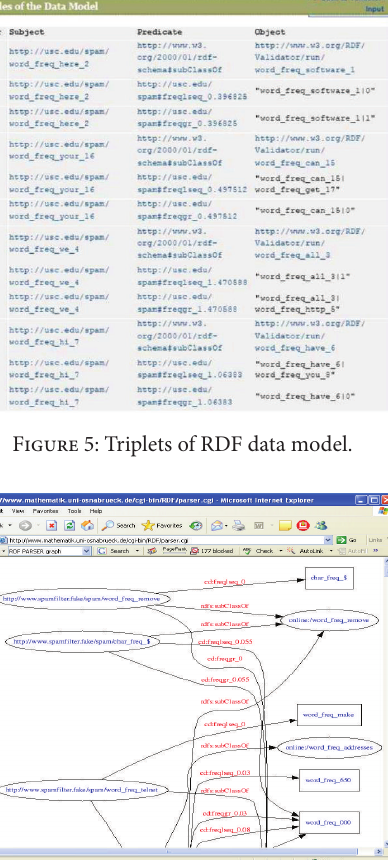
Table 8: Precision and recall of SPONGY